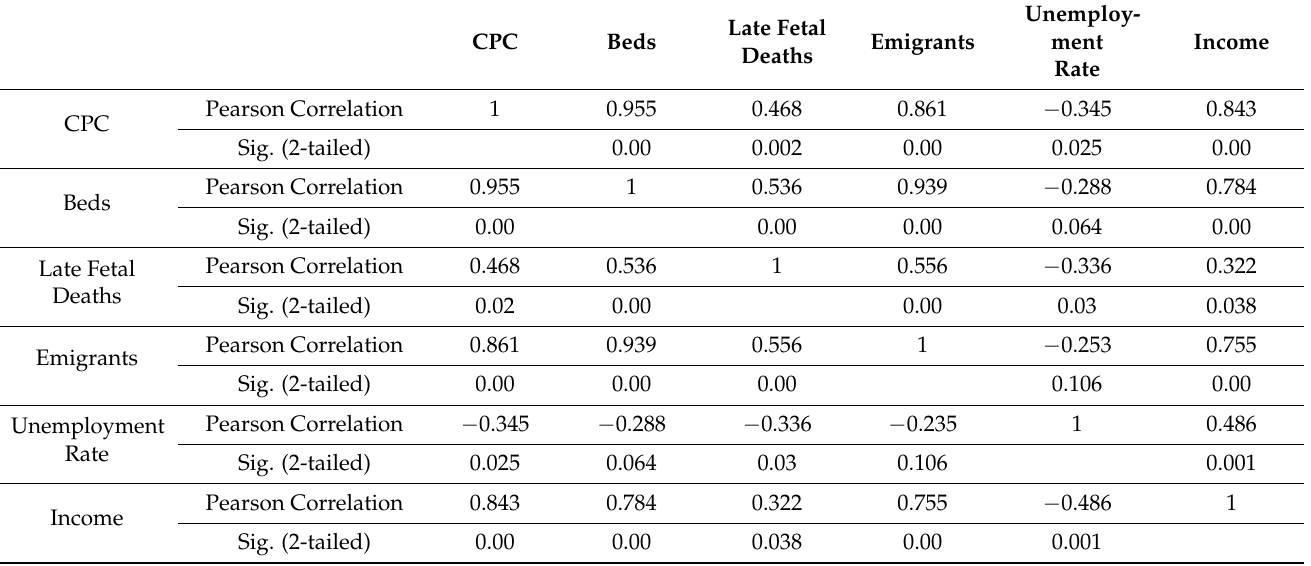
Table 1. Correlations,